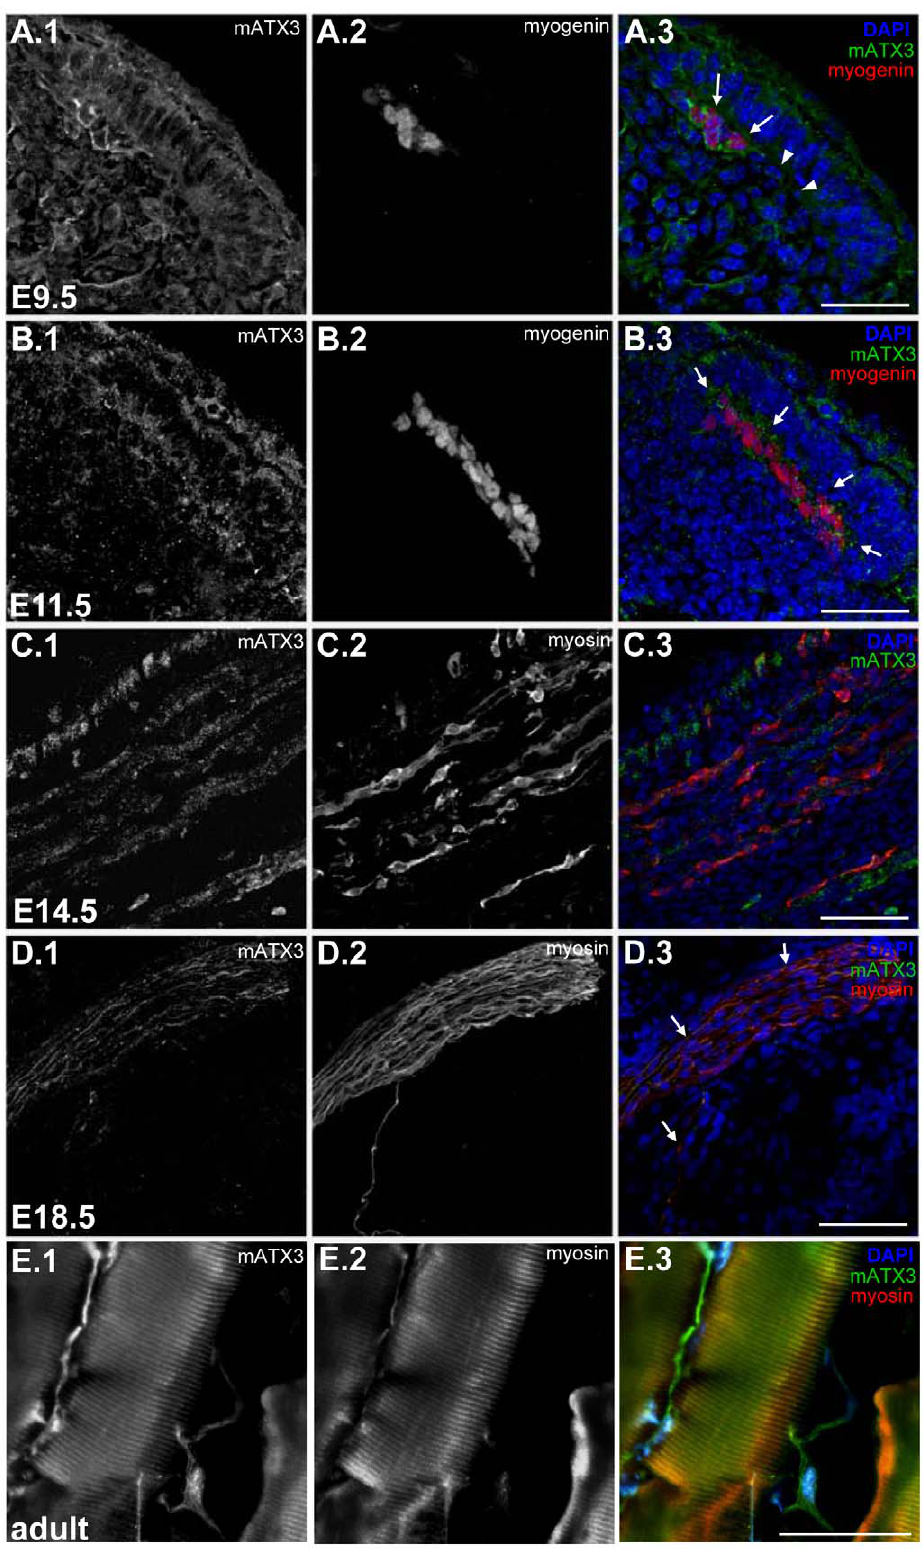
Figure 1. Mouse ataxin-3 (mATX3) is highly expressed in the early differentiated cells in the myotome,as well as in embryonic and adult muscle fibers. Maximum projection of confocal optical z-series from sagittal 15 m m sections of E9.5 (A), E11.5 (B), E14.5 (C) and E18.5 (D) mouse embryos labeled for mATX3 and the myogenic differentiation markers myogenin (A, B) or myosin (C, D). (A) mATX3 (green, arrows) is highly upregulated in differentiated myogenin-positive cells (red) when comparing with younger myogenin-negative cells in the myotome (arrowheads). (B) strong staining for mATX3 (green, arrows) remains present in E11.5 elongated myogenin-positive myocytes (red). (C) E14.5 intercostal muscle